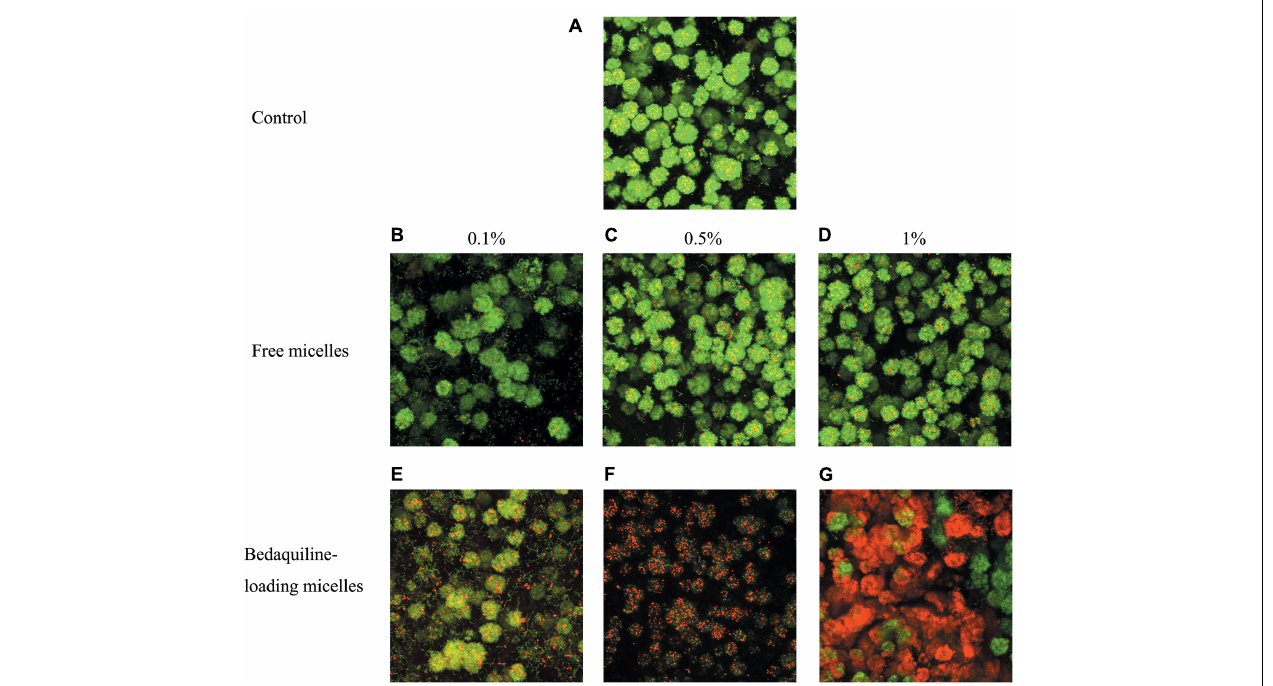
FIGURE 4 | Live/dead bacterial staining of S. mutans biofilm. Mature biofilm was shocked for 2 h by BHI broth (positive control A ), free micelles at 0.1% (B) , 0.5% (C) , 1% (D) ratio (v/v%), and bedaquiline-loading micelles at 0.1% (E) , 0.5% (F) , 1% (G) (v/v%). Green, live bacteria; red, dead bacteria; yellow, merged image of live and dead